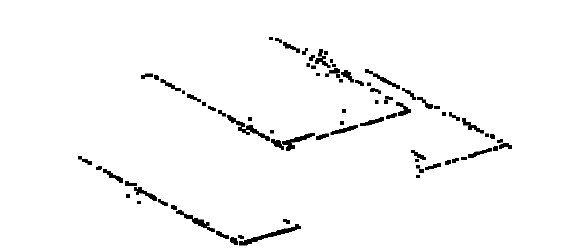
Figure 6: Top Edge Detection Result